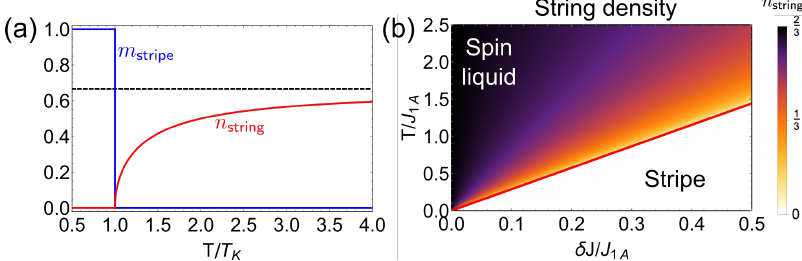
[ red, Eq. 49 ] , and the phase diagram for H [ Eq. 32 ] in the Figure 17: The string density, n string ABB constrained manifold. (a) Comparison between n string [ red, Eq. 49 ] and the stripe order parameter, m stripe [ blue, Eq. 2 ] . m stripe shows a step-like behaviour at the critical point, T = T K , while n string has Pokrovsky-Talapov critical behaviour, with n string ∝ ( T − T K ) β and β = 1 / 2 for small T − T K > 0. In the limit T → ∞ it saturates at n string = 2 / 3. (b) The phase diagram showing stripe and spin-liquid phases separated by a second-order transition at T = T K [ Eq. 44 ] , and overlaid with the string density, n string [ Eq. 45 ]